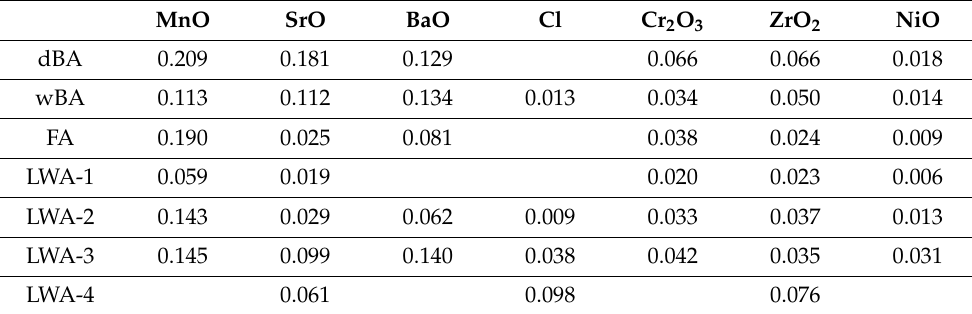
Table 5. Trace elements of coal ash and LWA (unit: %). MnO SrO